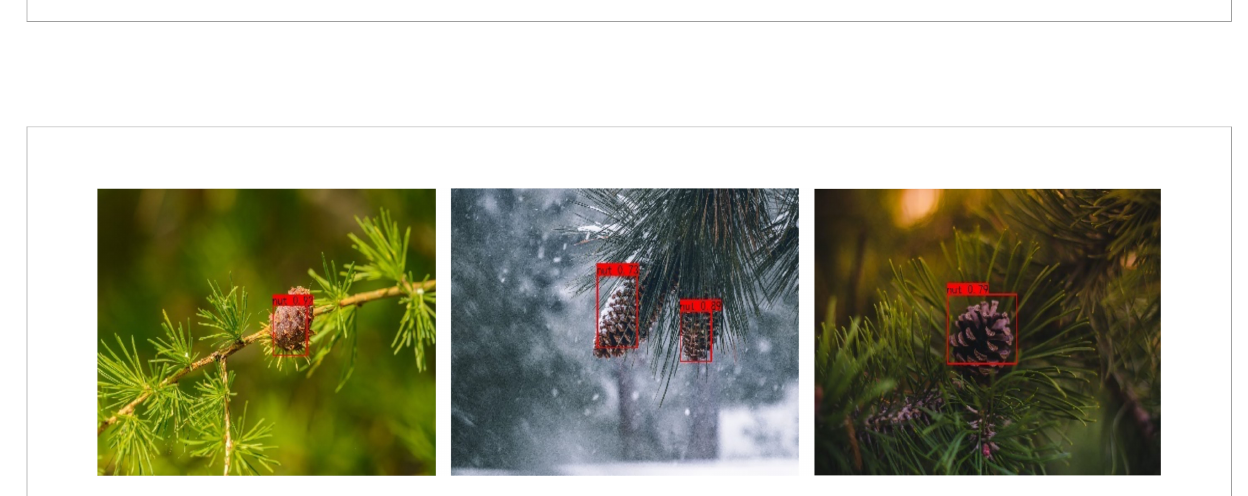
FIGURE 10 Pine cone detection based on EBE-YOLOV4.